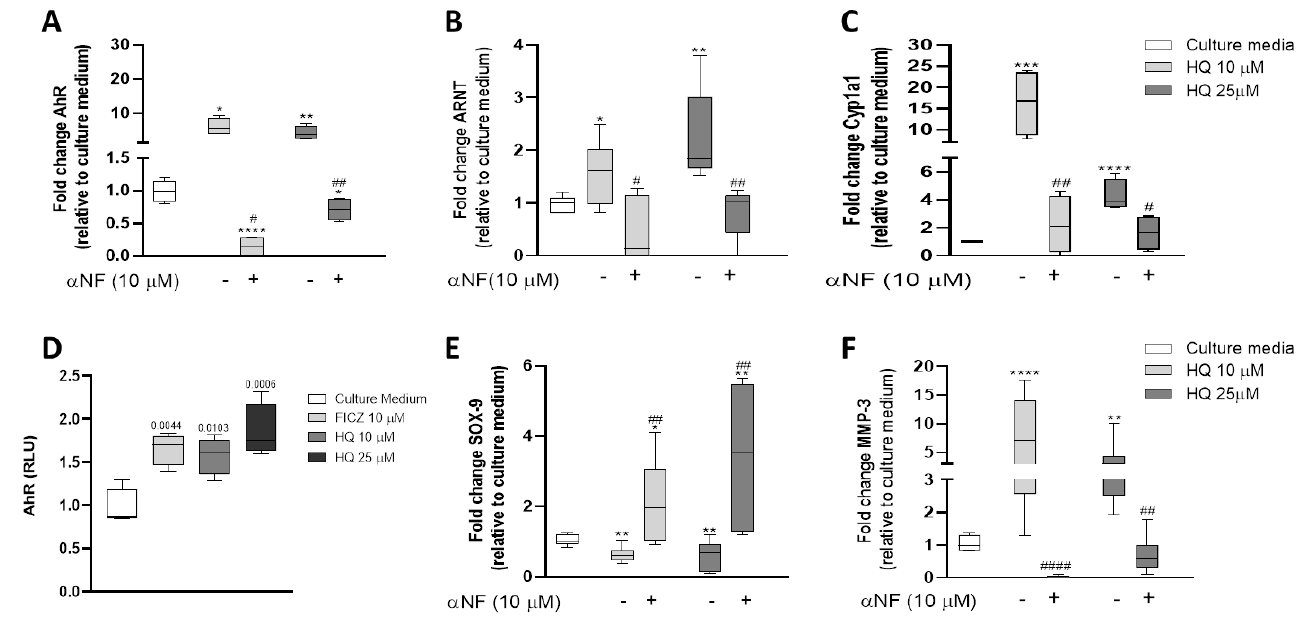
Figure 6. HQ activates the AhR pathway in articular chondrocytes: Modulation of components of the AhR pathway was determined by measuring mRNA levels of AhR, ARNT and Cyp1a1 in BACs incubated with CM or with HQ (10, 25 or 50 µM) in the absence or presence of αNF (10 µM) for 24 h ( A – C ). Results were normalised to the housekeeping gene β -actin and are expressed as fold change to CM. ( D ) Activation of the AhR receptor by HQ was confirmed through a luciferase-based reporter assay. Inhibition of AhR with αNF rescued the downregulation of SOX-9 ( E ) and the upregulation of MMP-3 ( F ) mediated by HQ. Data represent mean ± SEM from three independent experiments and were analysed by one-way ANOVA. * p < 0.05, ** p < 0.01, *** p < 0.001 and **** p < 0.0001 vs. CM; # p < 0.05, ## p < 0.01 and #### p < 0.0001 vs. αNF .